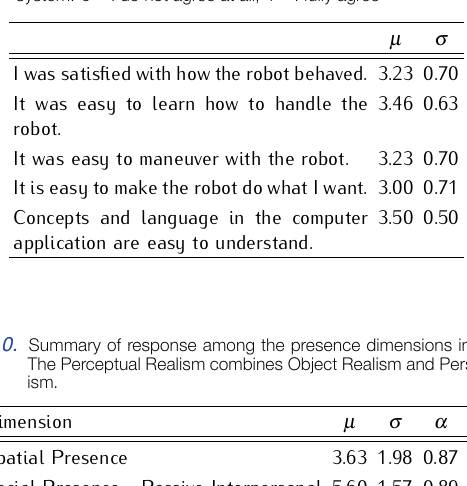
Table 8. A summary of the response regarding the perceived ease of use of the system. 1 = very difficult, 7 = very easy.